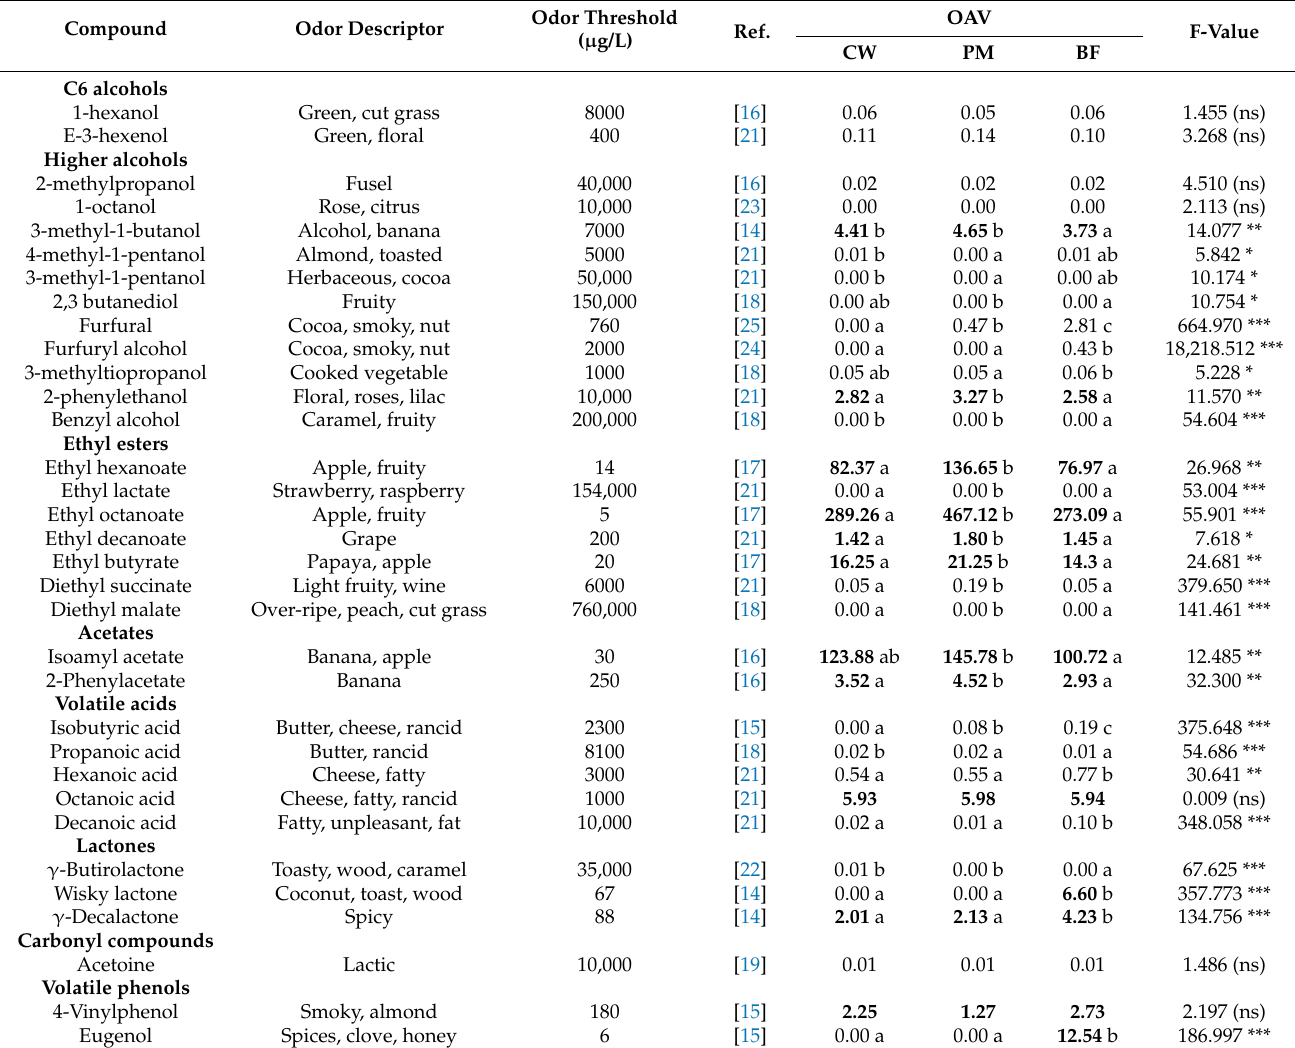
Table 3. Odor activity values (OAV) of Maturana Blanca wines produced by conventional winemaking (CW), conventional winemaking with pre-fermentative maceration (PM), and barrel fermentation (BF).